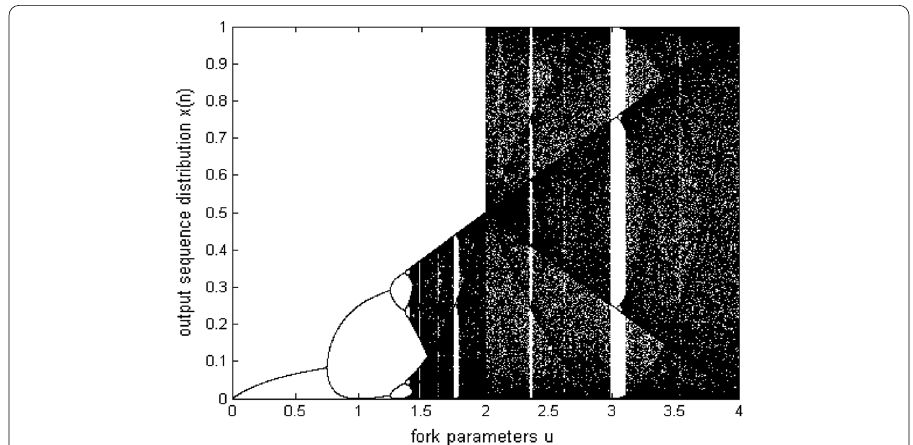
Fig. 3 Bifurcation diagram of segmented Logistic